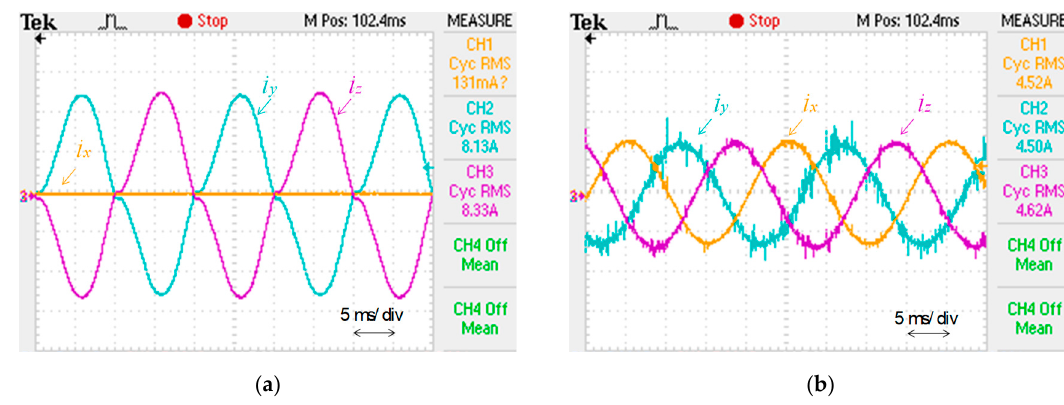
Figure 25. Experimental results (one load section is loaded): ( a ) before compensation; ( b ) after compensation. Phase x current ( i x : 5 A/div); phase y current ( i y : 5 A/div); phase z current ( i z : 5 A/div).